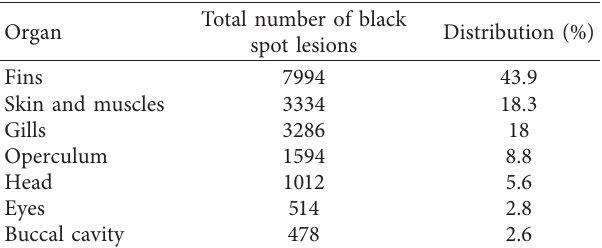
Figure 1: A Nile tilapia sampled from the farm showing multiple black spot lesions on the body (a). Black spot lesion embedded in the muscle (b) and on the gills rakers and filaments (c) of Oreochromis niloticus . Table 2: Percentage distribution of black spots in various organs of infested